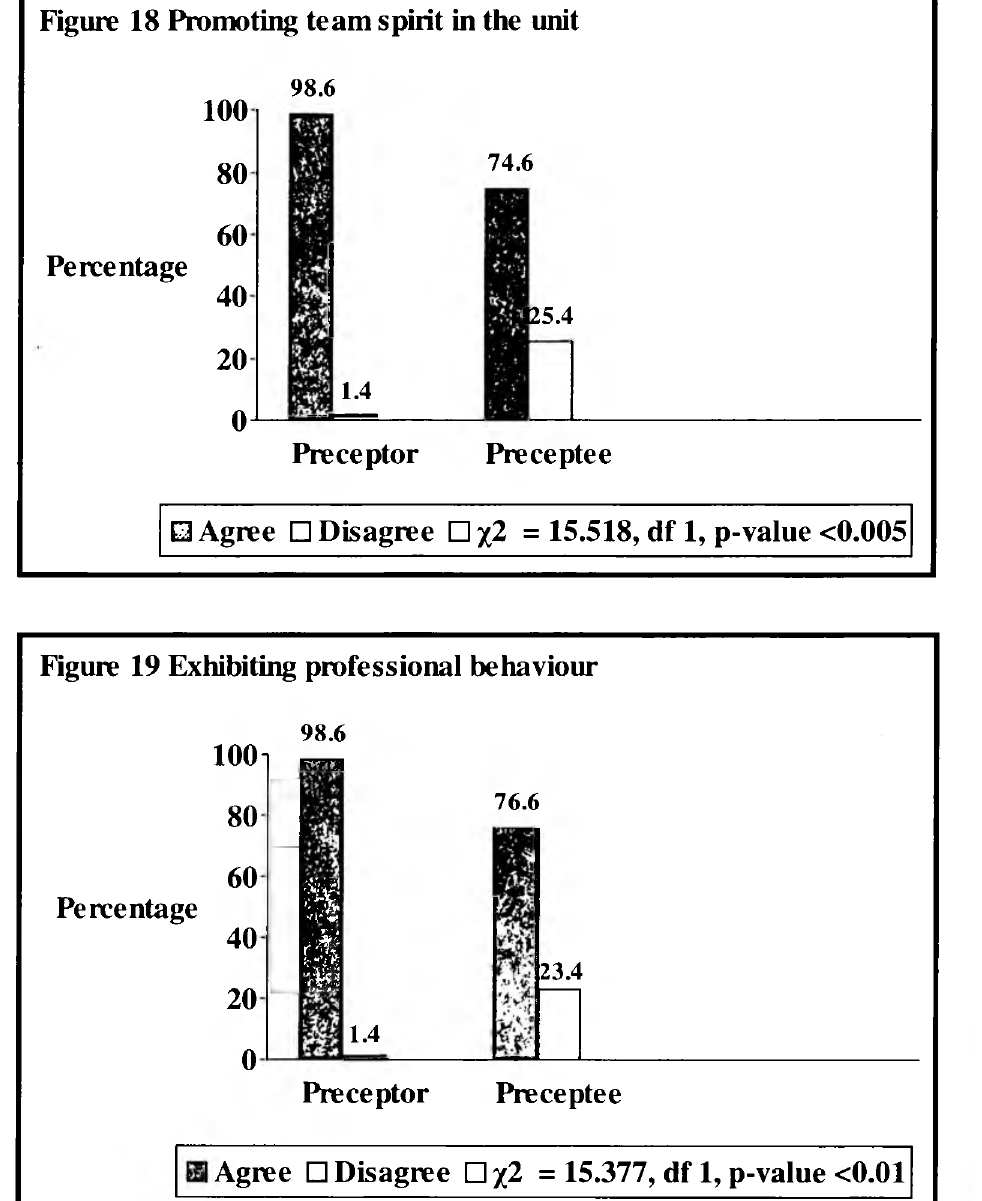
Figure 19 Exhibiting professional